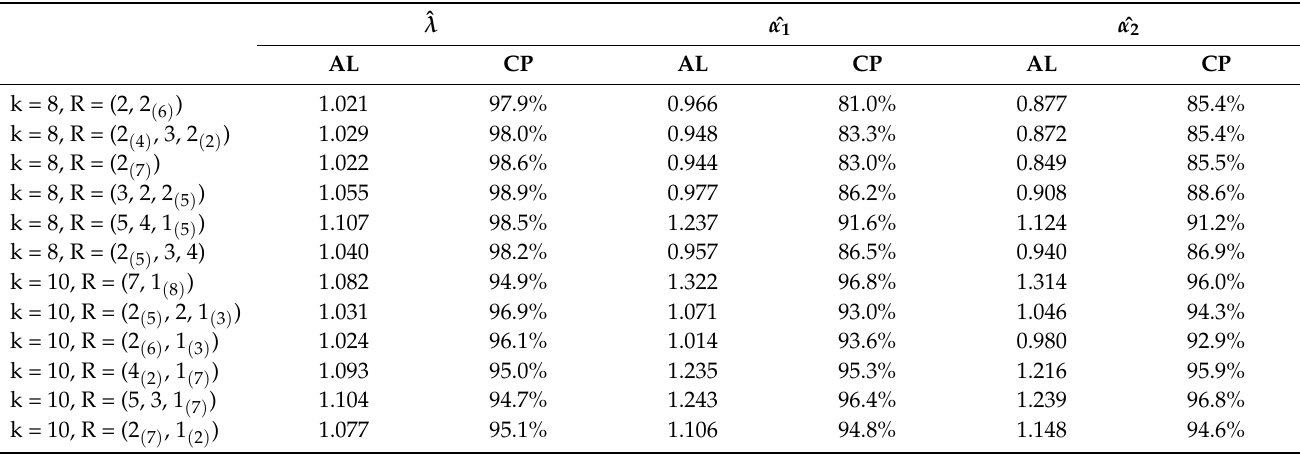
Table 4. CPs and ALs of 95% asymptotic confidence intervals of the model parameters with λ = 0.5, α 1 = 0.4, and α 2 = 0.3 based on different CSs.